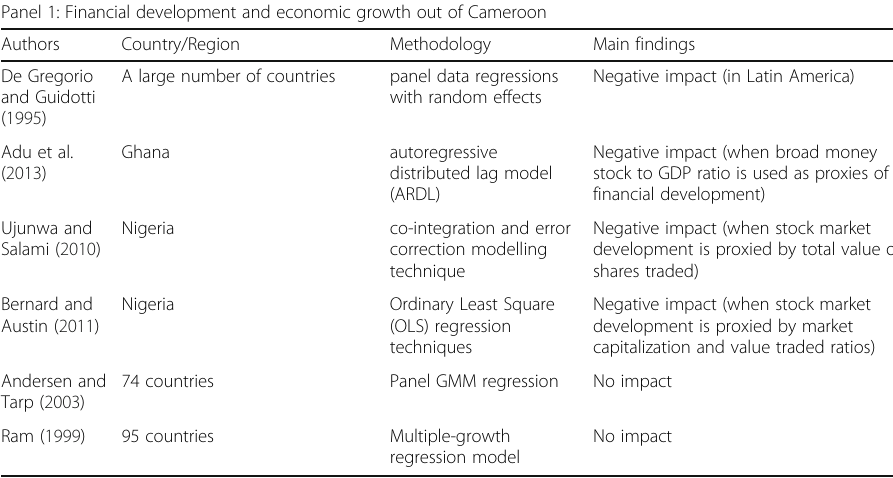
Table 1 Literature review excluding Cameroon (Continued) Panel 1: Financial development and economic growth out of